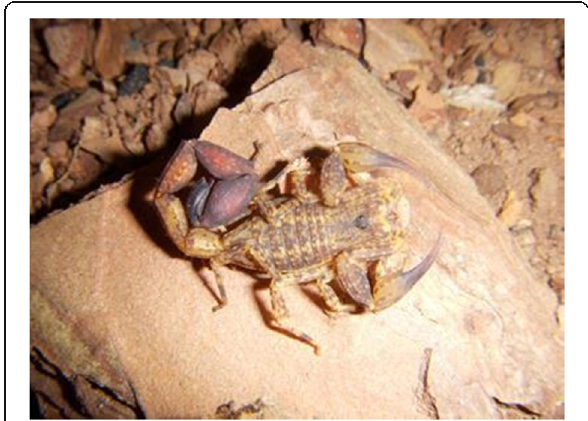
Fig. 6 Tityus silvestris. It is generally yellowish brown with spots all over the body, legs and palps. It can measure from 2.5 to 4.5 cm in length. Source: Brazilian Ministry of Health [6]. Image copyright by Denise Cândido, reproduced with